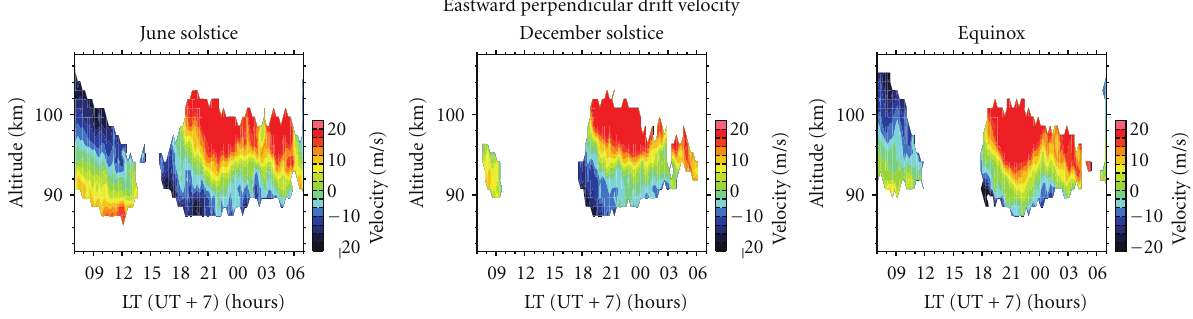
Figure 5: Same as Figure 4 but for the Doppler velocity toward the